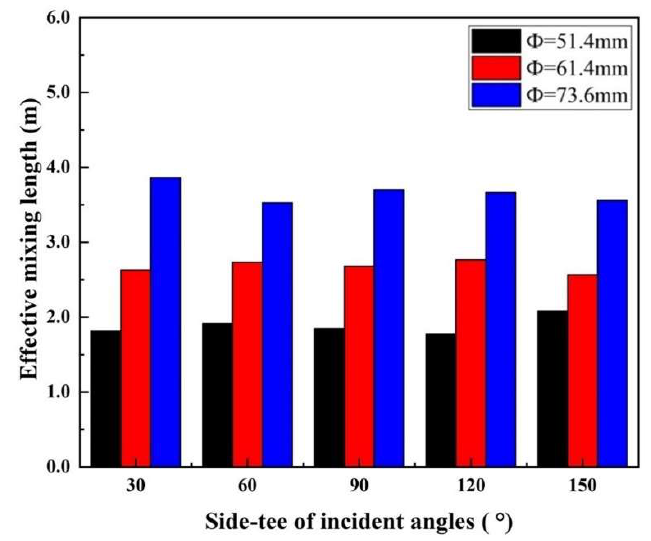
Figure 8. Variation tendency of L EML under three kinds of main pipe diameters: ϕ = 51.4 mm; ϕ = 61.4 mm; ϕ = 73.6 mm.